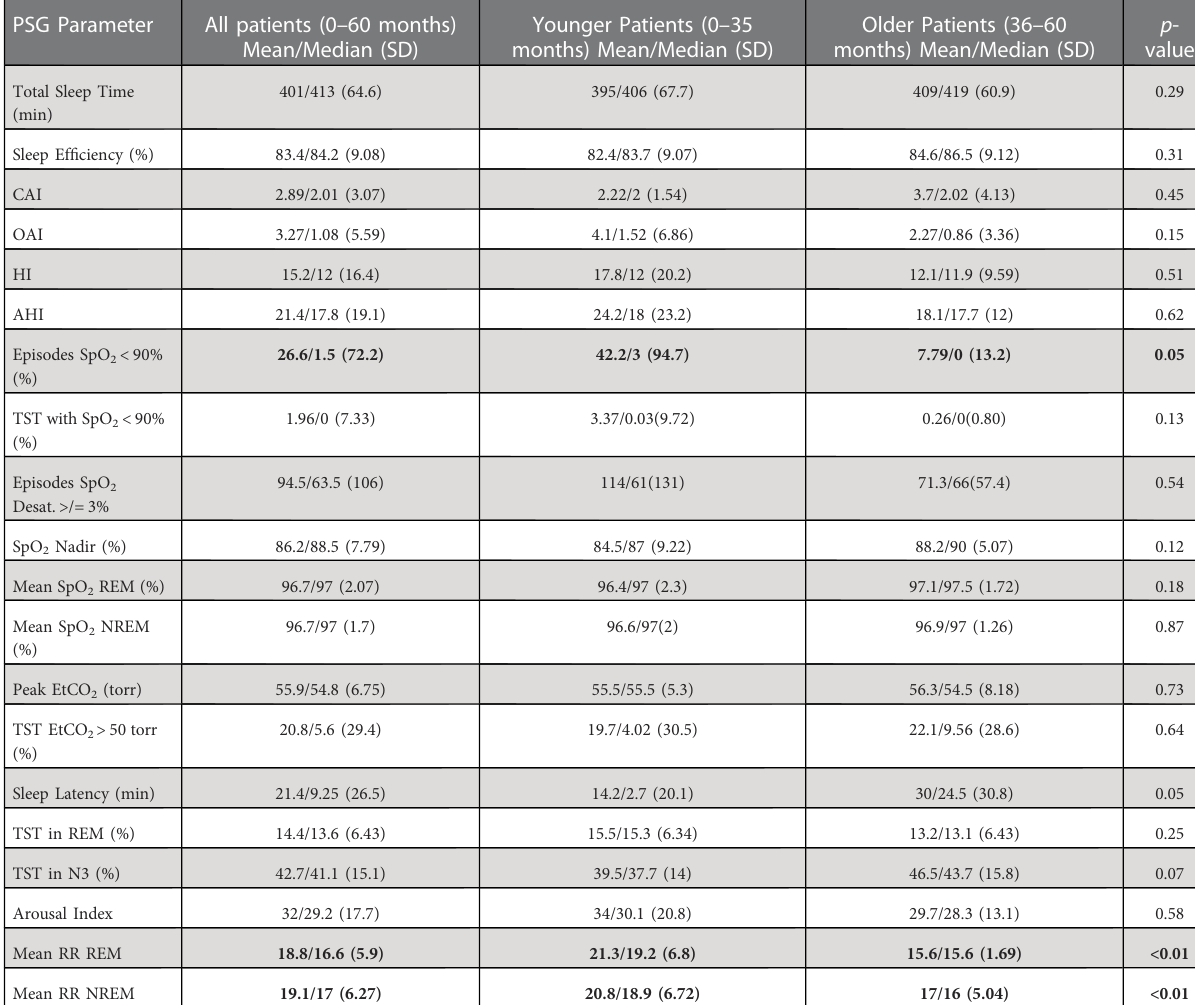
TABLE 3 Polysomnography